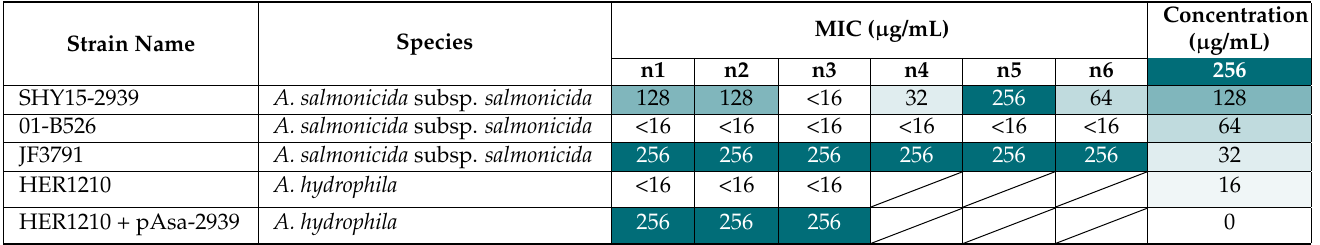
Table 2. MIC of chloramphenicol at 18 ◦ C for A. salmonicida subsp. salmonicida and at 37 ◦ C for A. hydrophila